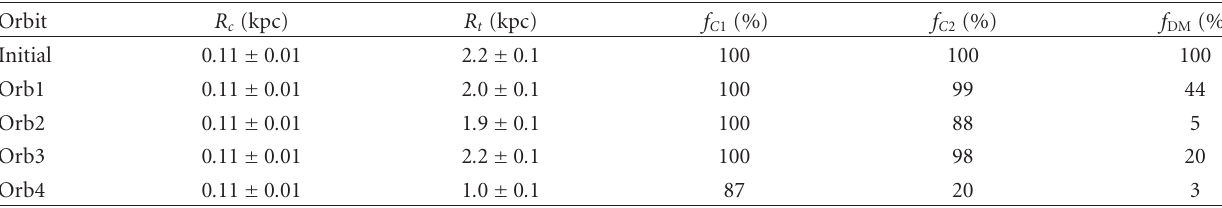
Table 1: Structural properties of the satellite models after its evolution for t = 6 ( ± 0 . 3) Gyr within the fixed Galactic potential. The first row in the table shows the initial values and subsequent rows show the present-day values for the experiments on Orb1–Orb4. R c and R t refer to the best-fitting King profile values to the surface density profile of the luminous components. The last 3 columns indicate the fraction of mass in each component that remains bound to the dwarf in the final